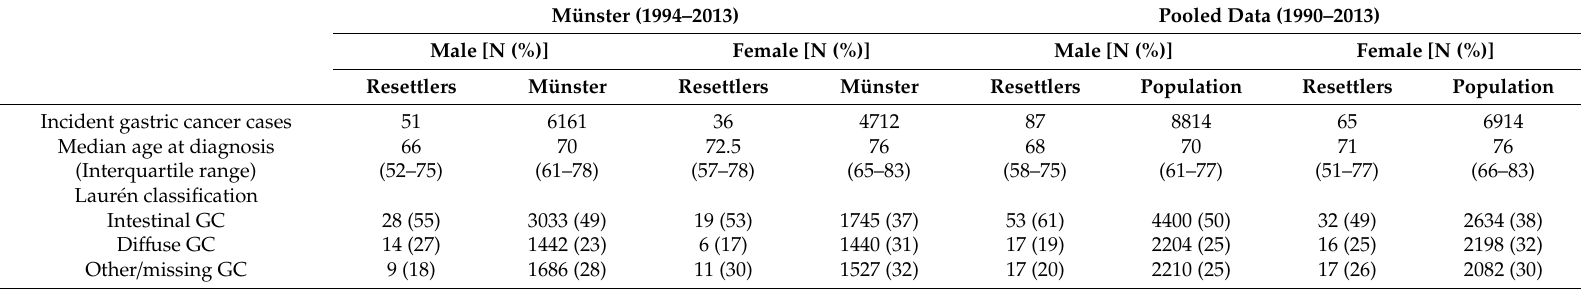
Table 2. Characteristics of resettlers and the general population in Münster, and of resettlers and the general population in Münster and Saarland combined (pooled